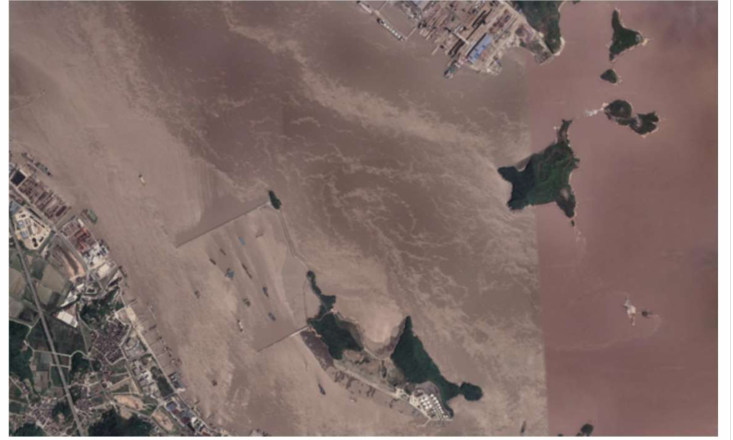
Figure 13. Luotou Channel in the Zhoushan Archipelago (Google Earth 29 ◦ 55 (cid:48) 19.99 (cid:48)(cid:48) N and 122 ◦ 05 (cid:48) 07.00 (cid:48)(cid:48) E).